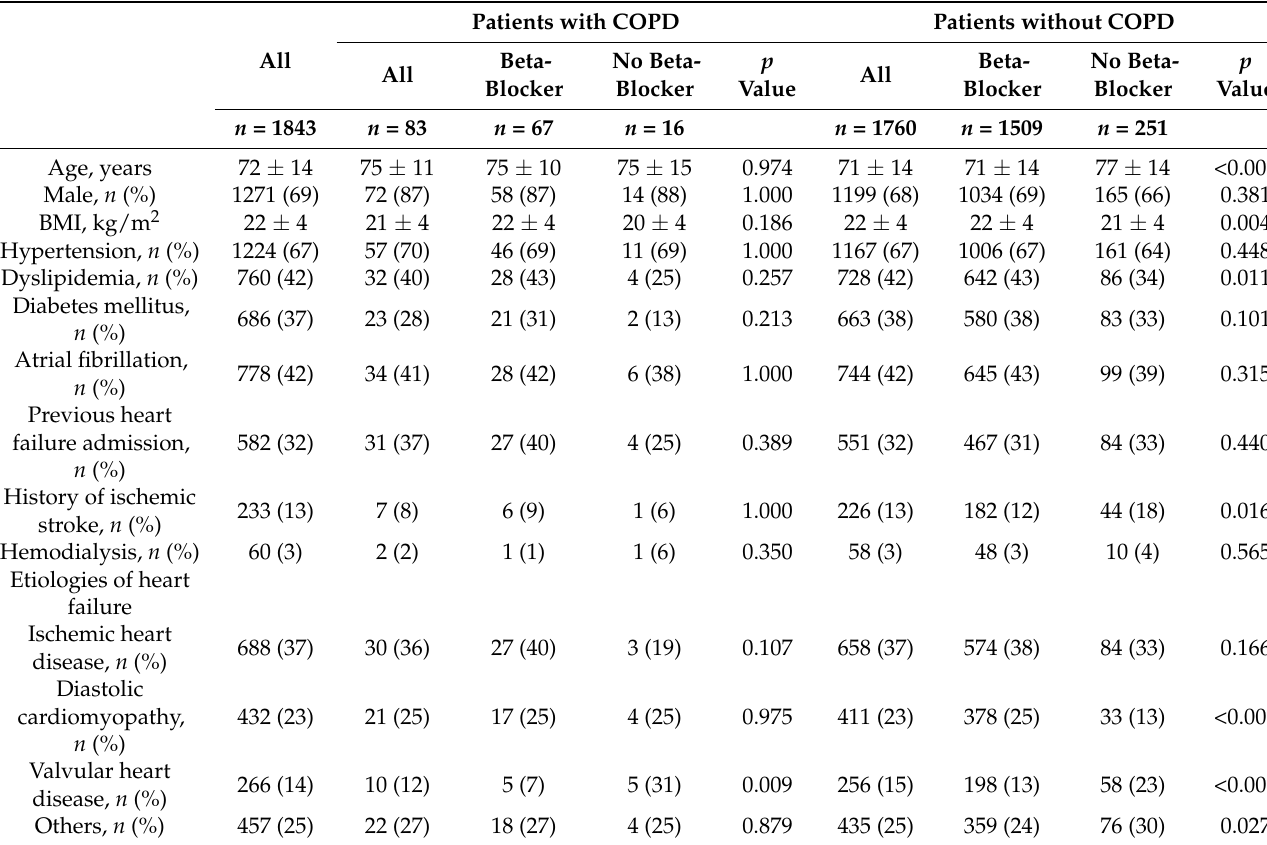
Table 1. Patient